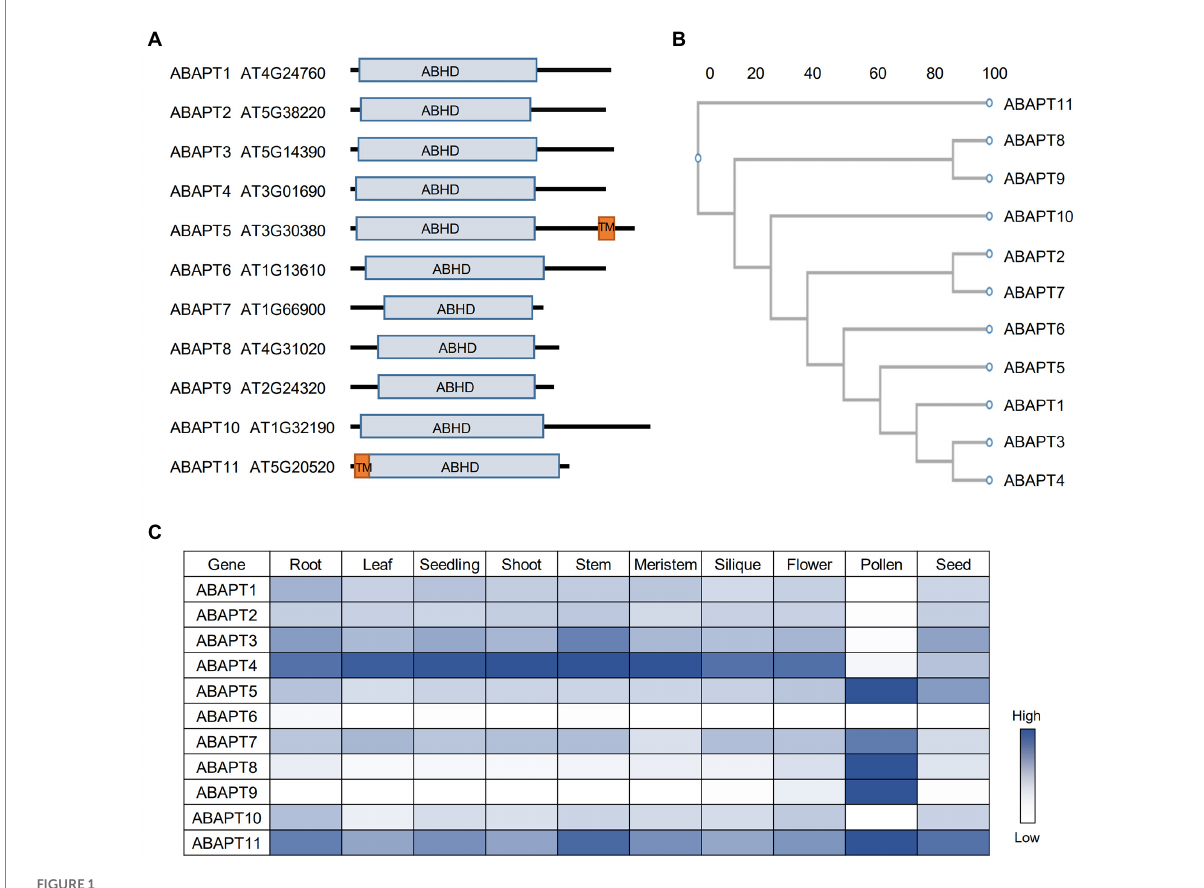
FIGURE 1 The ABAPT family in Arabidopsis . (A) Protein domain architecture of ABAPT family proteins. ABHD, alpha beta hydrolase domain; TM, transmembrane domain. (B) Phylogenetic tree of the Arabidopsis ABAPT family proteins. The phylogenic tree was conducted using protein sequences and the neighbor-joining method was used. Scale bar indicates genetic distance. (C) Expression profiles of all ABAPT genes in different tissues. The heat map shows the relative expression level of each gene. All the gene expression data were retrieved from Arabidopsis RNA-seq Database